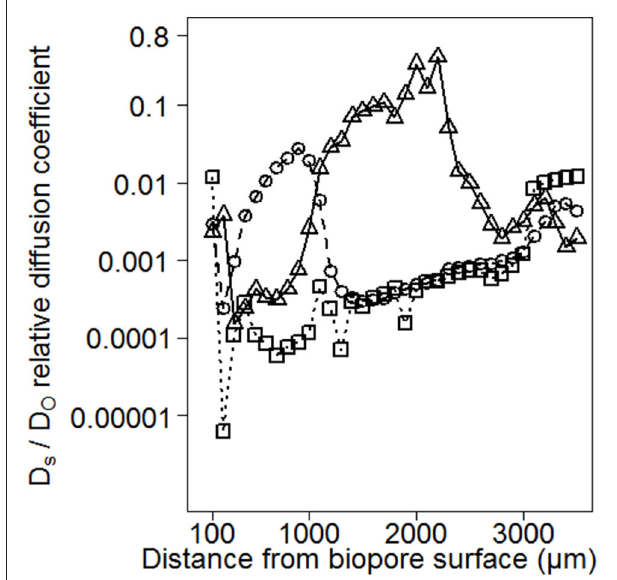
FIGURE 5 | Consequences of small-scaled differences in aggregation for D s /D O exemplarily for three replicated measurements within the same biopore wall. Deviations up to several orders of magnitude are observed for the